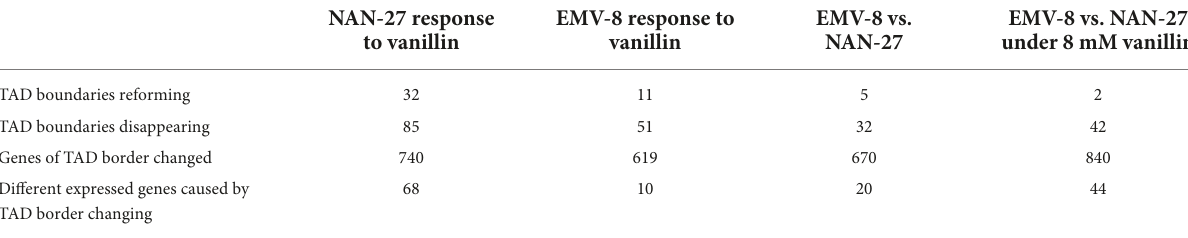
TABLE 1 The number of TAD boundaries changing and of the differentially expressed genes caused by TAD border changing.